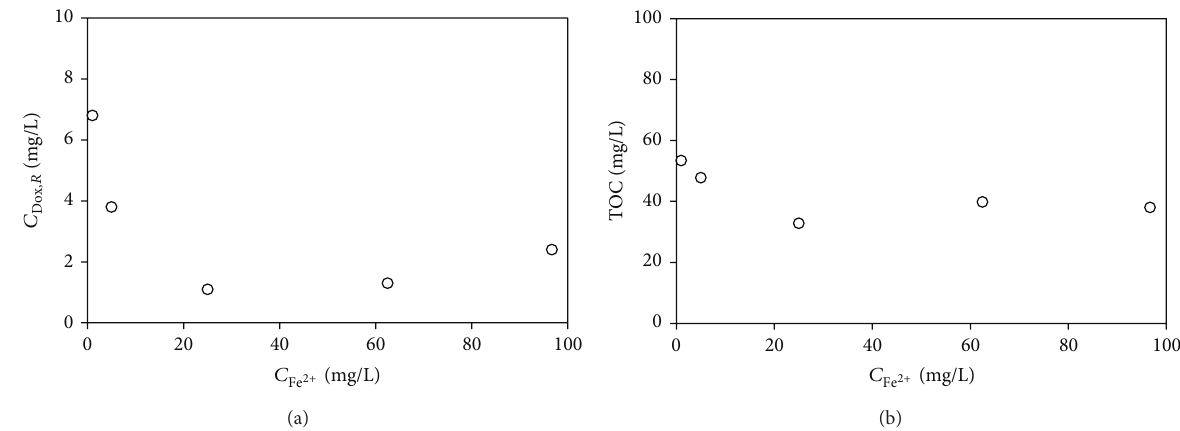
Figure 4: Influence of initial concentration of ferrous ion ( 𝐶 carbon (TOC) at the end of the Fenton